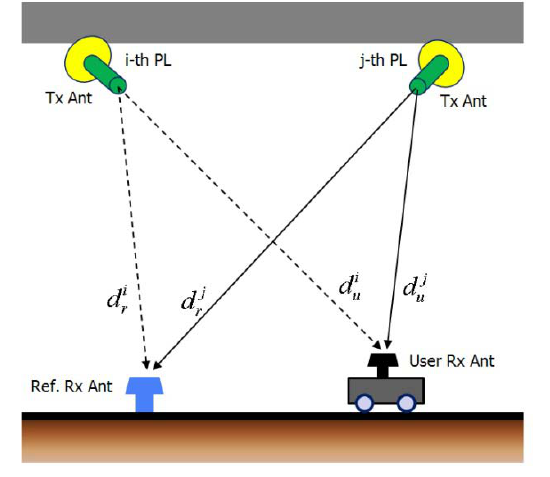
Figure 8. Measurement model of an asynchronous PL navigation system